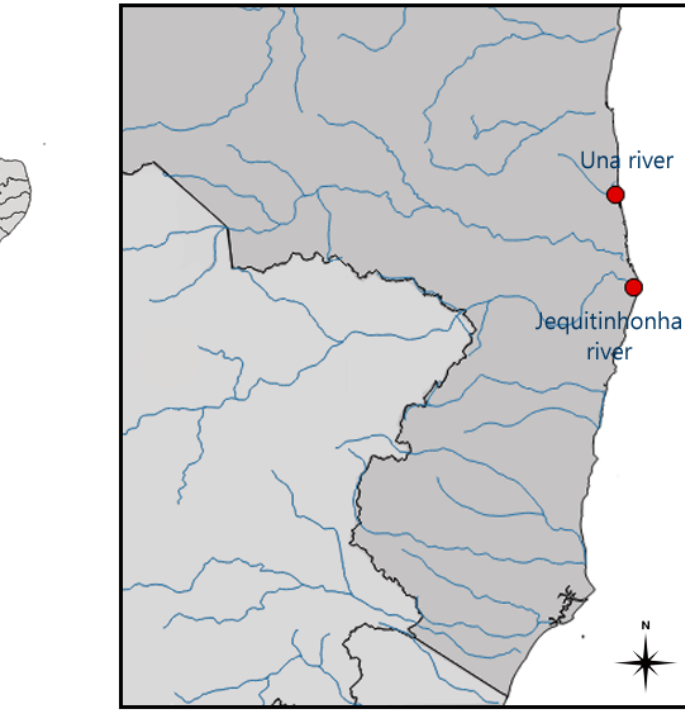
Figure 1. Occurrence records of Anthalona neotropica Sousa, Elmoor-Loureiro and Debastiani-Júnior, 2015 in southern Bahia